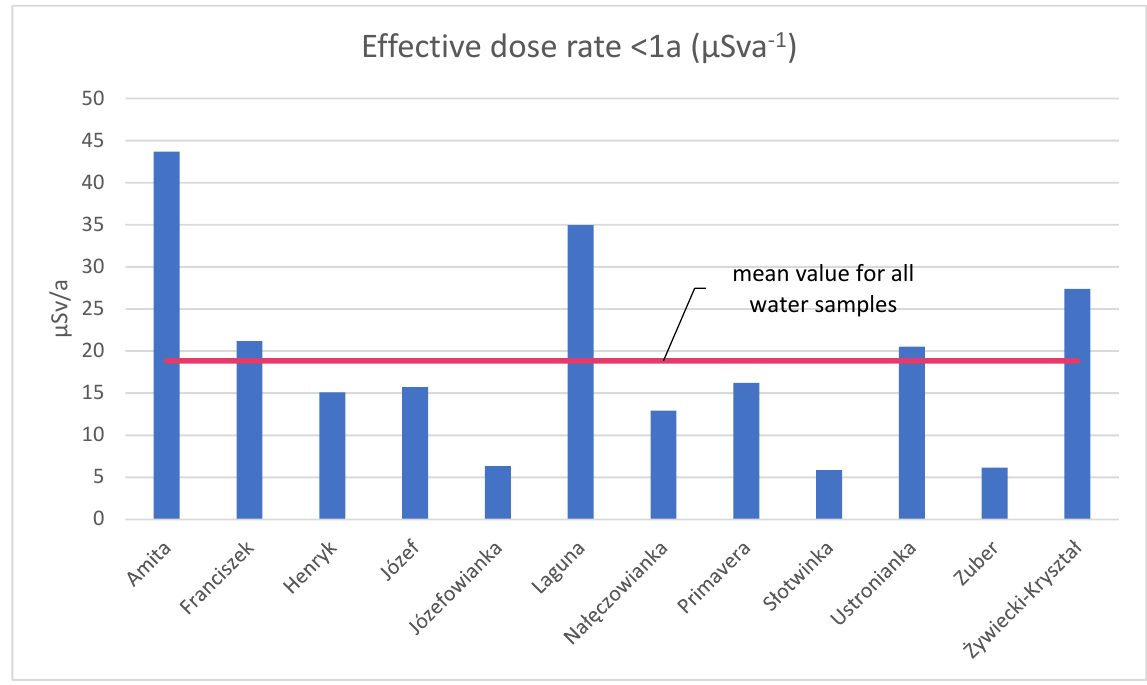
Figure 3. Annual effective dose for children under 1 year of age from the consumption of individual mineral waters.